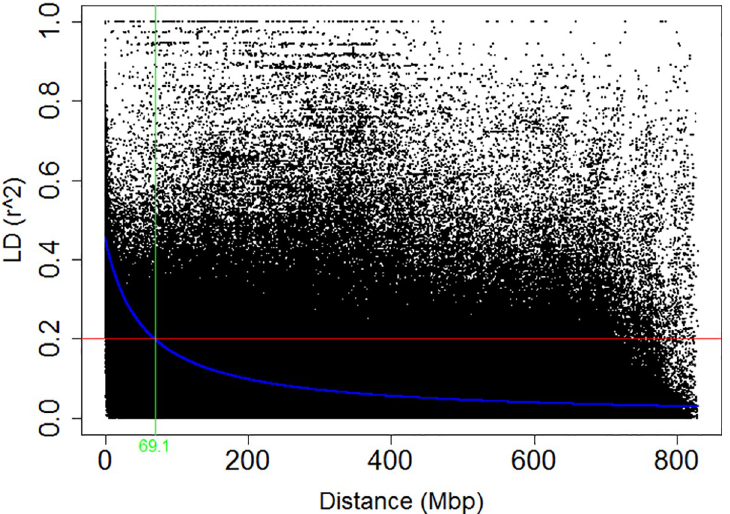
Fig 6. Genome-wide linkage disequilibrium as dictated by physical distance. Average pair-wise inter-SNP LD ( r 2 ) values plotted against physical distance in base pairs based on the wheat reference genome RefSeq v.1.0. The red line indicates the threshold